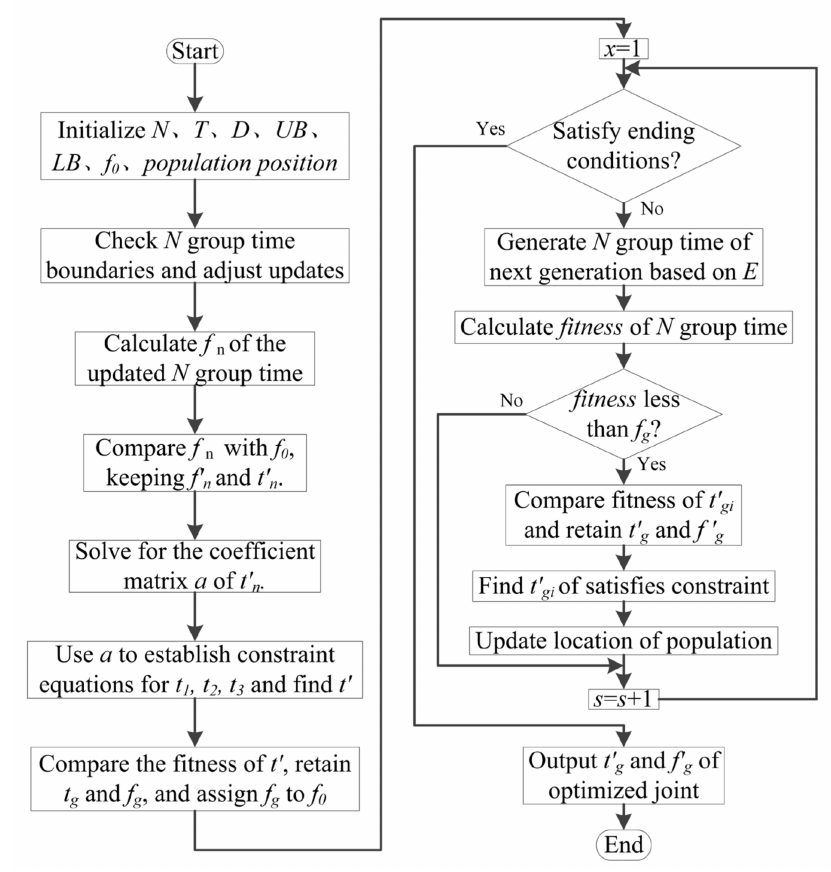
Figure 7. Robot time‑optimal trajectory planning process.